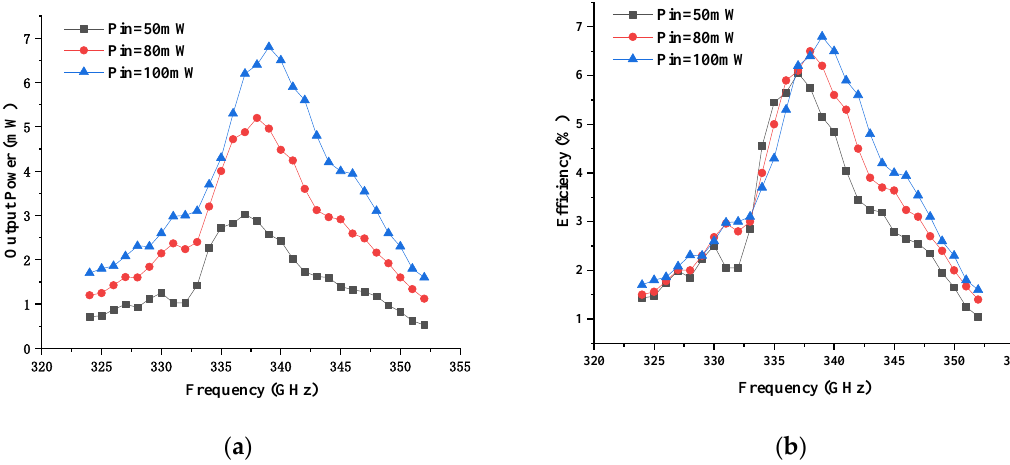
Figure 11. Schematic diagram of the 0.34 THz tripler’s output power test setup.